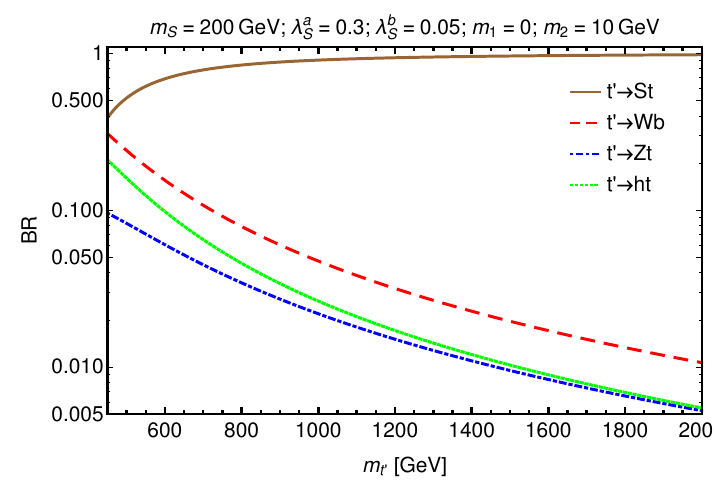
Figure 1 . BRs of t 0 as a function of the mass for a speci(cid:12)c parameter